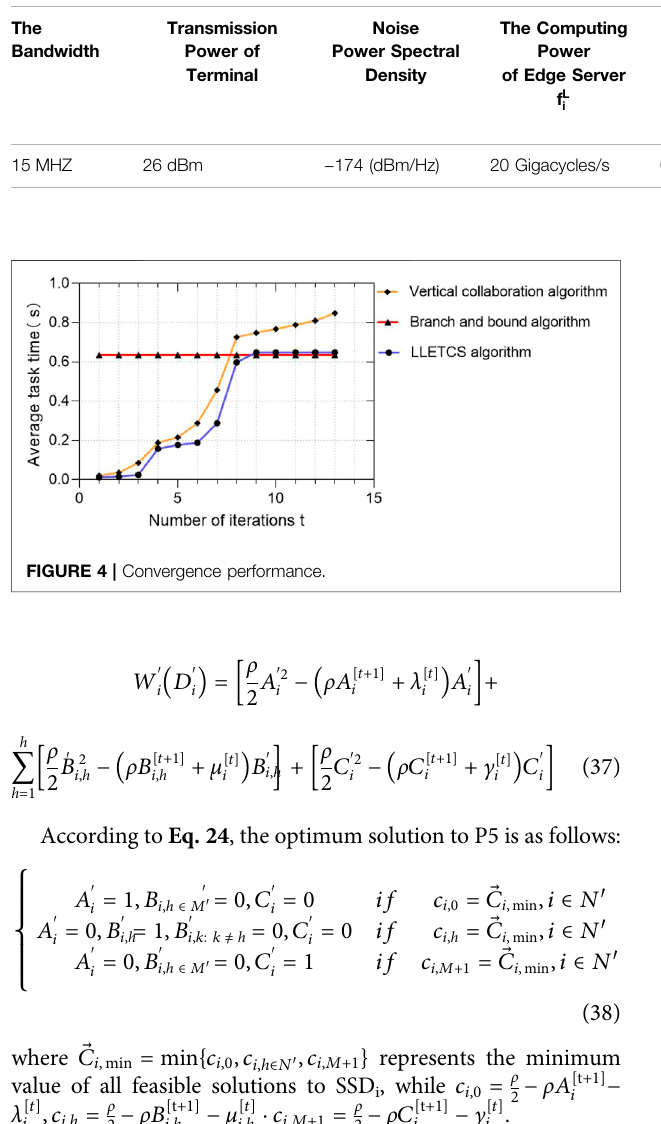
TABLE 1 | Description of simulation experiment parameters.